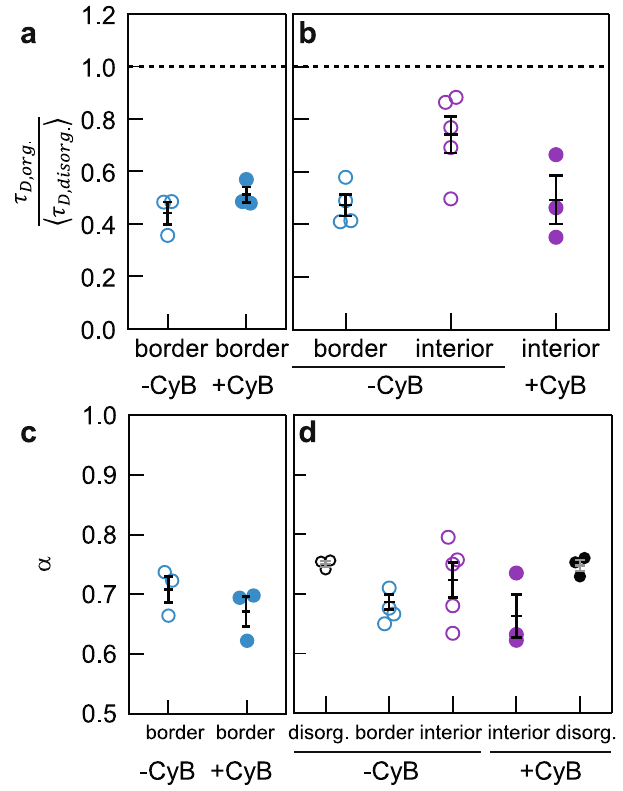
Fig. 5 | Protein diffusionin actin-intact extracts. a , b Normalizeddiffusion times of BSA in actin-intact extracts, prepared without the addition of cytochalasin B (CyB). Note that the diffusion rate did not increase more during the self- organization of actin-intact extracts (open circles) than it did in actin-inhibited extracts (solid circles). The two panels are two independent experiments. c , d Degree of subdiffusion in actin-intact and actin-inhibited extracts. Data shown inpanel c and d arefromthesameexperimentshowninpanel a and b ,respectively. Error bars, SEM. n ={3, 3, 4, 5, 6; 3, 3, 3, 4, 5, 6, 3} measurements of different positions in an extract for data from left to right and top to bottom, respectively. Source data are provided as a Source Data fi